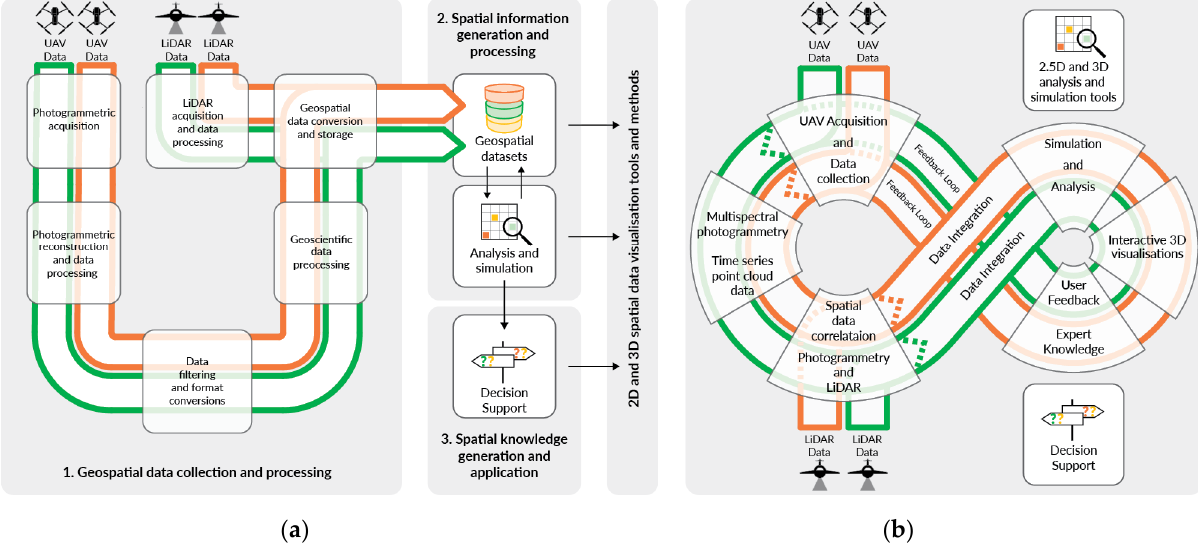
Figure 11. Workflows for generating spatial knowledge via ( a ) a conventional sequential approach and ( b ) the proposed composite voxel model (CVM)-based approach. This figure is available in Supplementary Materials (Figure S2) as a high-resolution, full page illustration.